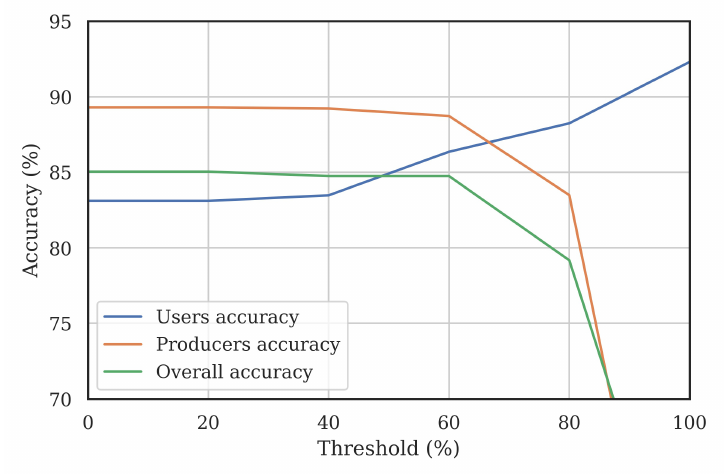
Figure 15. Trading average producers’ and users’ accuracies, by adjusting the threshold for proportion of pixels in each segment belonging to the majority